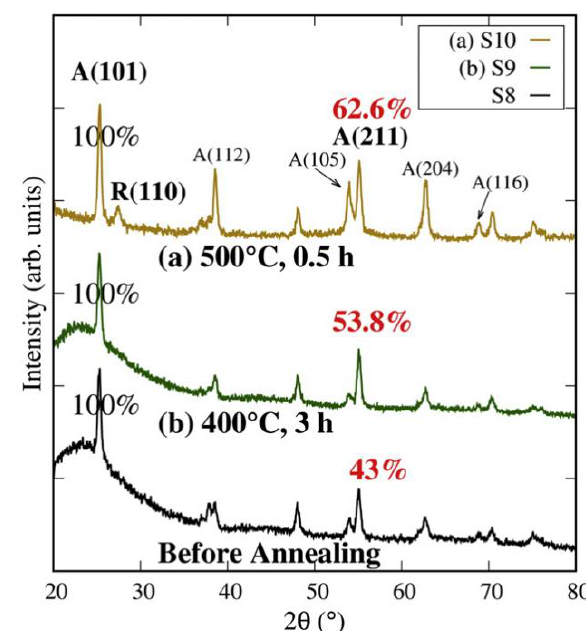
Figure 15. XRD pattern of anatase TiO 2 thin film annealed at (a) 500 °C 0.5 h and (b) 400 °C 3 h. Each noted percentage is the ratio of XRD intensity of A(211) to that of A(101). ‘A’ and ‘R’ represent anatase and rutile phase, respectively. Reprinted with permission from [186], copyright 2017, Elsevier.